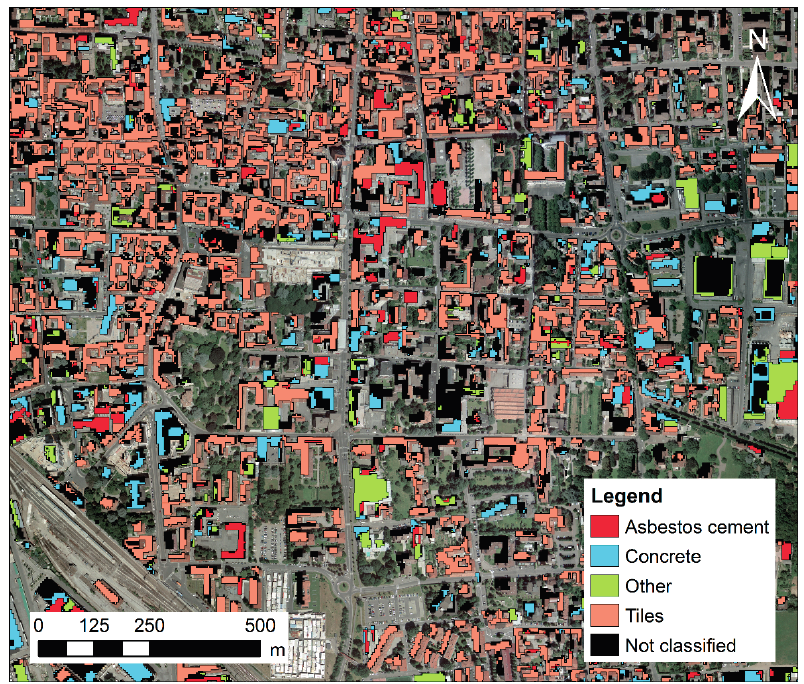
Figure 5. An example of classification results obtained through the SAM (Spectral Angle Mapper) algorithm on an urban area (Seregno, MB,